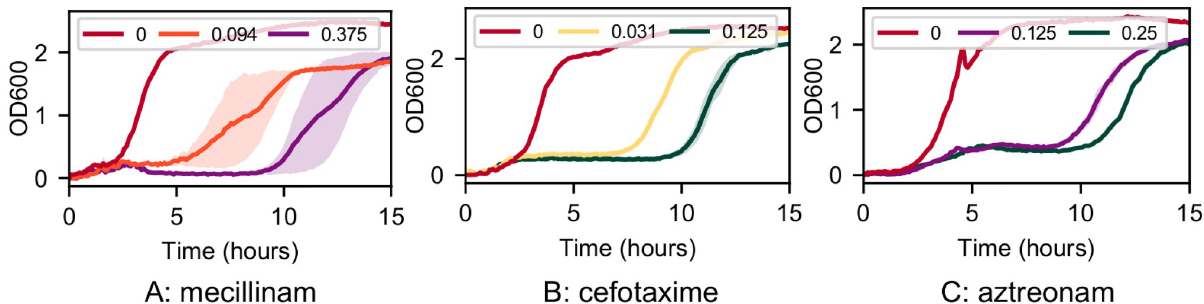
Fig 2. Typical growth curves in the presence of β -lactam antibiotics. Growth curves, measured in the plate reader, for E. coli strain RJA002 (see Methods) in MOPSgluRDM, in the presence of A: mecillinam, B: cefotaxime and C: aztreonam. The legends show the antibiotic concentration, in units of μ g/ml. Growth curves are averaged over two replicates. The standard deviation between the replicates is represented by the shaded area around the lines.